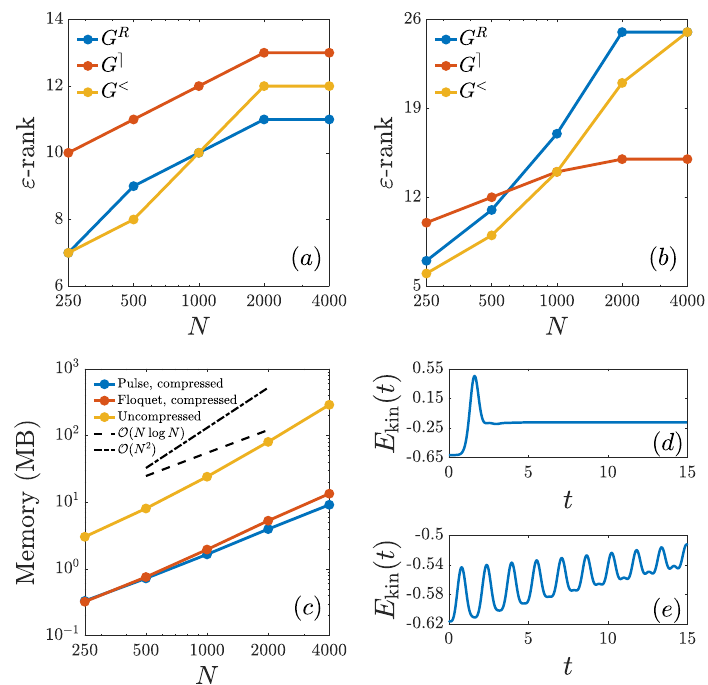
Figure 9: Ranks and memory usage for the GW examples with increasing propagation times T corresponding to N time steps of fixed size ∆ t , computed offline from solu- tions obtained using the NESSi library. Panels (a) and (b) give (cid:34) -ranks for the pulse and ramp examples, respectively, with (cid:34) = 10 − 4 . Panel (c) gives the total memory usage in each case using compressed and direct storage. Panels (d) and (e) show the time evolution of the kinetic energy for the pump and Floquet examples,